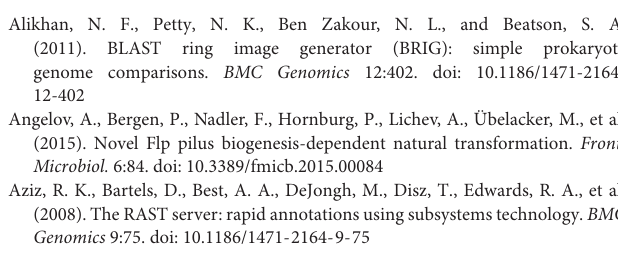
FIGURE S2 | Electron microscopy of appendages of C. acnes and assessment of their